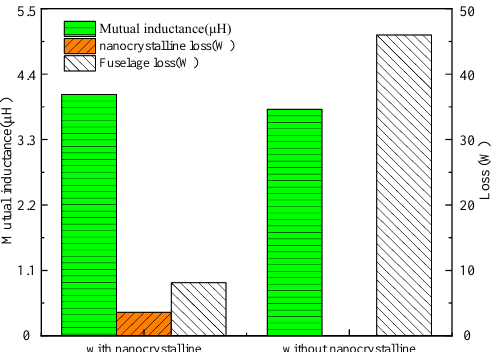
Figure 11. Comparison between the fuselage with and without nanocrystalline.